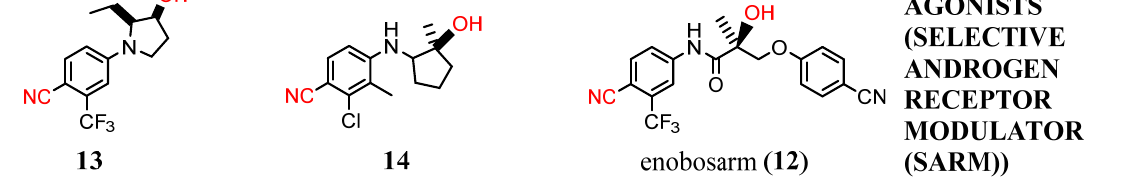
Figure 1. Overview of canonical androgen receptor (AR) ligands. Resistance to ADT such as gonadotropin ‐ releasing hormone agonist or antagonist (or alternatively surgical castration) results in progression to CRPC. Subsequent or concomi ‐ raterone; and/or antiandrogens such enzalutamide ( 3 ), apalutamide ( 4 ), or darolutamide is inevitable. Several mechanisms have been attributed to these resistances including over ‐ expression of the AR, mutations in the AR ligand ‐ binding domain (LBD), loss of AR (neu ‐ roendocrine PCa), constitutively active AR splice variants (AR ‐ SVs), increase in intra ‐ tumoral hormonal synthesis, and activation of growth factor pathways [8]. Over time, as